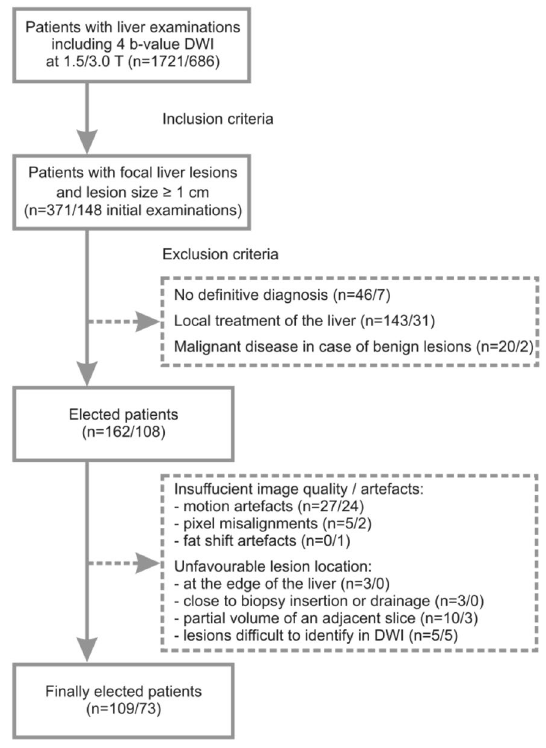
Figure 1. Flow chart of inclusion and exclusion criteria of the study sample.